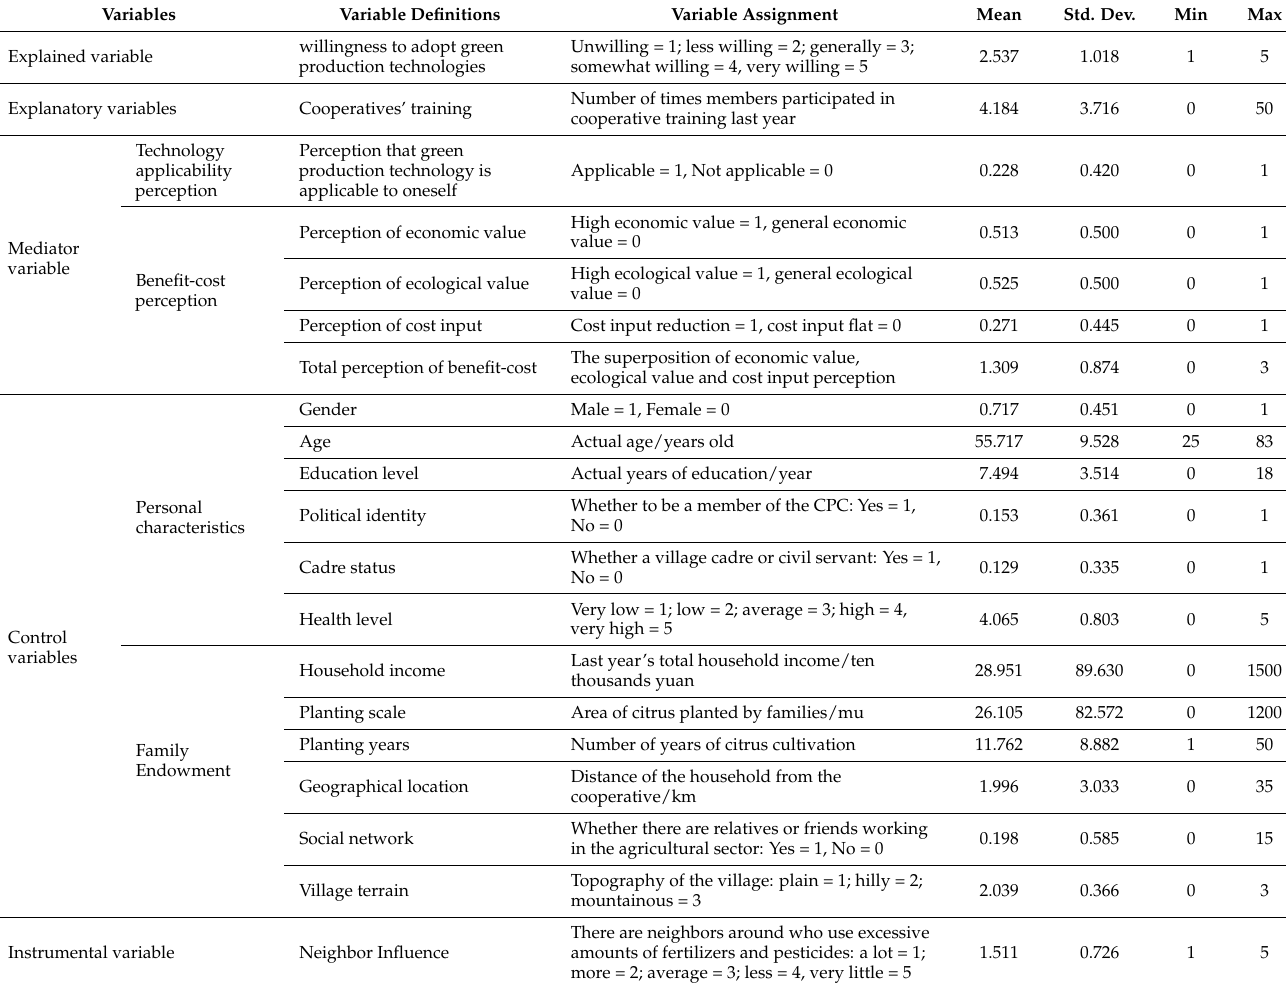
Table 2. The meaning and assignment of